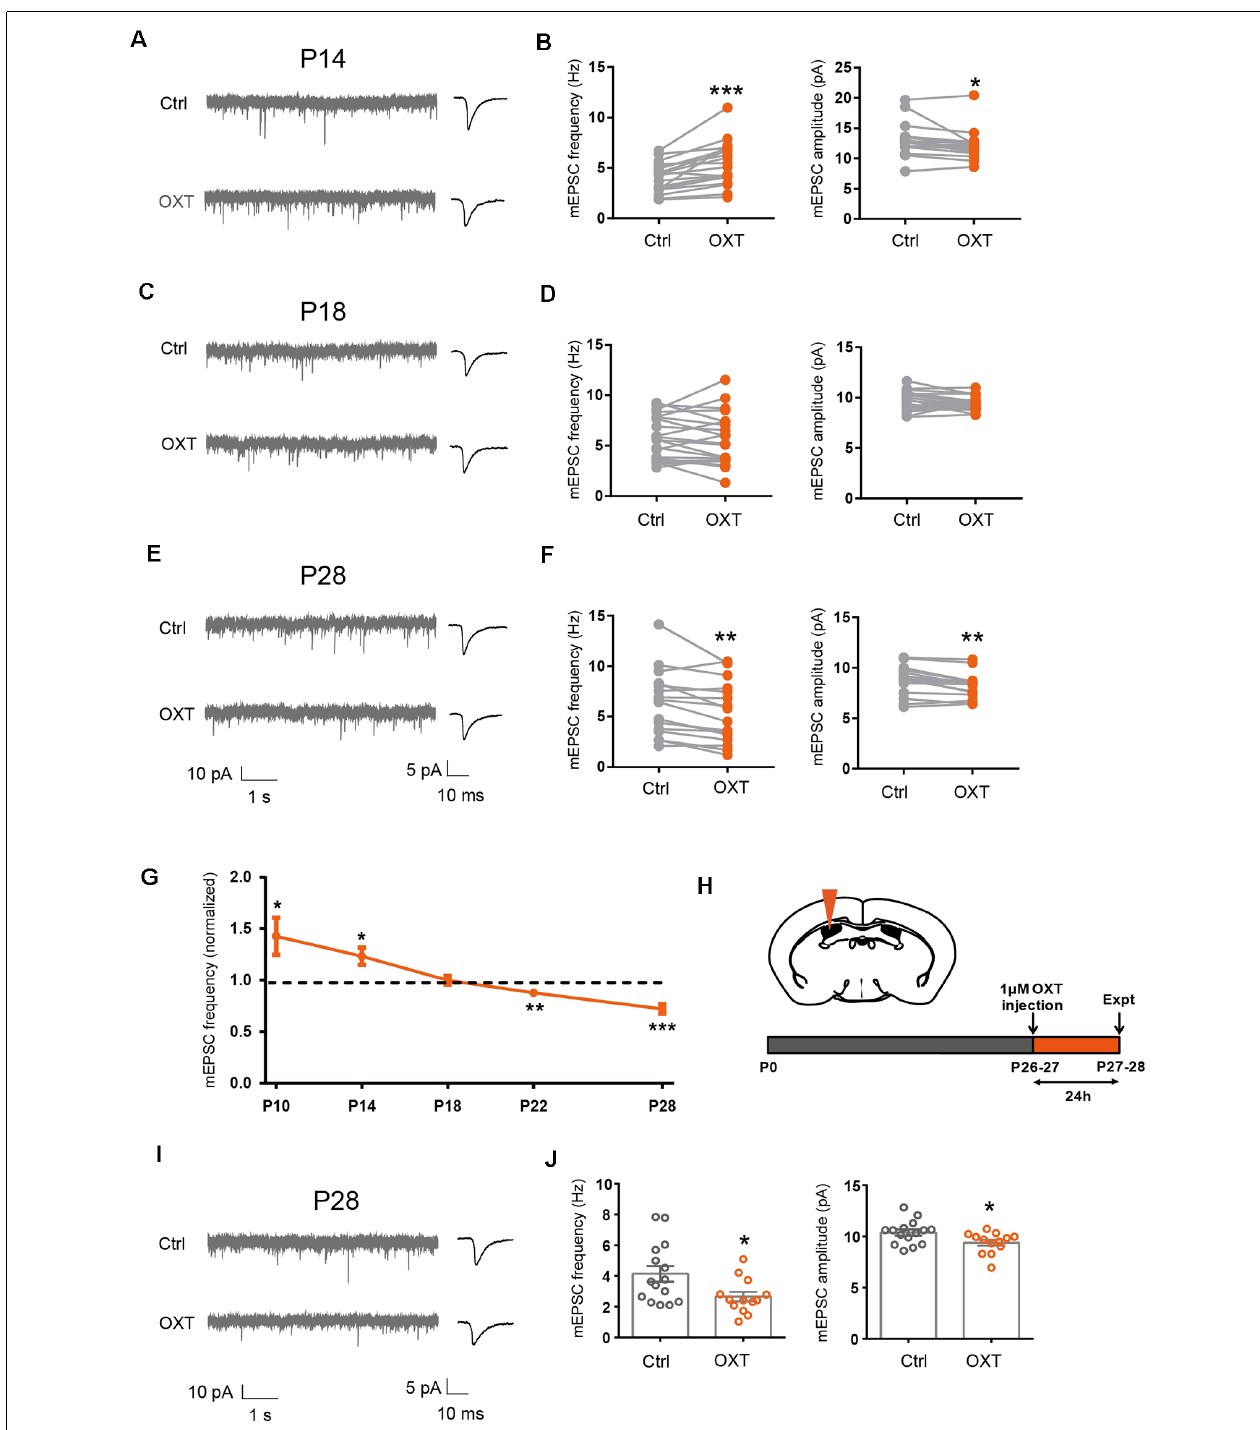
FIGURE 1 | Dynamic regulation of excitatory synaptic transmission by oxytocin. (A,C,E) Representative mEPSC recordings (left) and average waveforms (right) from S1BF L2/3 pyramidal neurons before (Ctrl) and after oxytocin (OXT) application, age as indicated. (B) Oxytocin application increased mEPSC frequency but reduced mEPSC amplitude in P14 mice (frequency: Ctrl, 4.10 ± 0.35 Hz; OXT, 5.43 ± 0.52 Hz; n = 18; P < 0.001, paired t -test; amplitude: Ctrl, 13.01 ± 0.63 pA; OXT, 12.17 ± 0.58 pA; P < 0.05, paired t -test). (D) Oxytocin application did not significantly affect mEPSC frequency or amplitude at P18 (frequency: Ctrl, 5.80 ± 0.47 Hz; OXT, 5.65 ± 0.57 Hz; n = 21; P = 0.60, paired t -test; amplitude: Ctrl, 9.71 ± 0.21 pA; OXT, 9.39 ± 0.15 pA; P = 0.08,